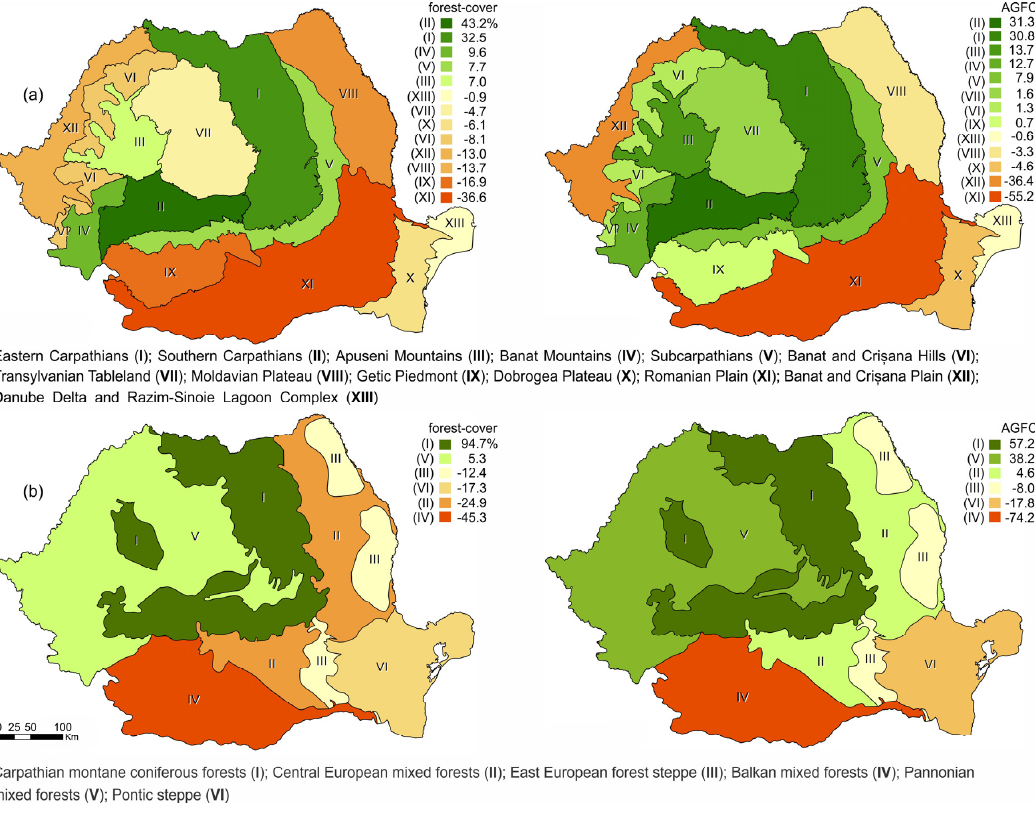
Figure 9. The regional spatialization of the projected forest-cover dynamics and the resulting change in the aboveground forest carbon stock for 2006–2050 (calculated as the percentage of the total changes), according to the major landform units ( a ) and the major vegetation ecoregions ( b ). In terms of major vegetation ecoregions, the total projected forest gain in the Carpathian montane coniferous forests (94.7% of the total) and Pannonian mixed forests (5.3% of the total) has resulted in a percentage of 95.4% of the total AGFCS increases: 57.2% in the Carpathian montane coniferous forests and 38.2% in the Pannonian mixed forests. The projected forest loss in the Balkan mixed forests (45.4% of the total), the Pontic steppe (17.3% of the total) and the East European forest steppe (12.4% of the total) has resulted in a drop in AGFCS by 74.2%, 17.8% and 7.9%, respectively. However, the projected forest loss in the Central European mixed forests (24.9% of the total) has resulted in 4.6% of the total AGFCS increases. 4. Discussion The baseline AGFB model used in the present approach overestimates the total quantity by about 17% compared to the estimated amount reported in the FAO’s Global Forest Resource Assessment [43] and the Executive Report of the European Map of Living Forest Biomass and Carbon Stock [10]. An overestimation (11%) was also found compared to the estimated amount reported in the “Use of National Forest Inventories data to estimate the biomass in the European Forests”—Final report [92]. Furthermore, converting the total standing wood volume (m 3 ) estimated by [93] to tons by using the mean conversion figure 1 m 3 = 725 kg [94], our overestimates increase to 22.3% for the all estimated amount, and to 4.7% for the estimated quantity per ha. By comparing the resulting values for the dominant forest species [93], the AGFB model exceeds by 34.6% the estimated quantity for deciduous species, but is inferior by 10.4% for coniferous species. Additionally, according to the